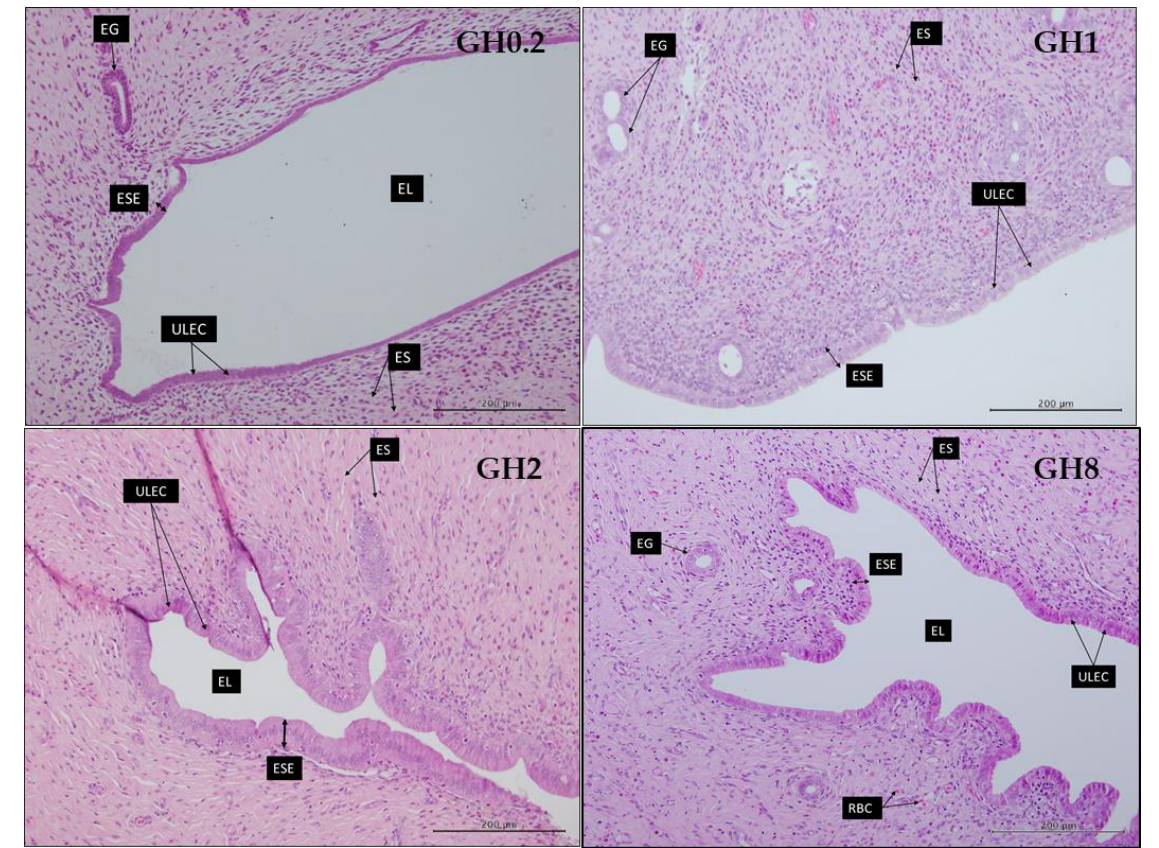
Figure 8. Structure of the rat uterine epithelium following a 14-day administration of Gelam honey (GH) at different dosages. The uterine epithelium initially became thicker in GH1 and GH2 but thinned with an increasing GH dosage. GH0.2 (0.2 g GH/kg bw/day); GH1 (1 g GH/kg bw/day); GH2 (2 g GH/kg bw/day); GH8 (8 g GH/kg bw/day). UE: uterine epithelium; ULEC: uterine luminal epithelial cells; ESE: endometrial surface epithelium; ES: endometrial stroma; EG: endometrial gland; EL: endometrial lumen. The issues were stained with an H&E stain. All measurement bars are equivalent to 200 µm.